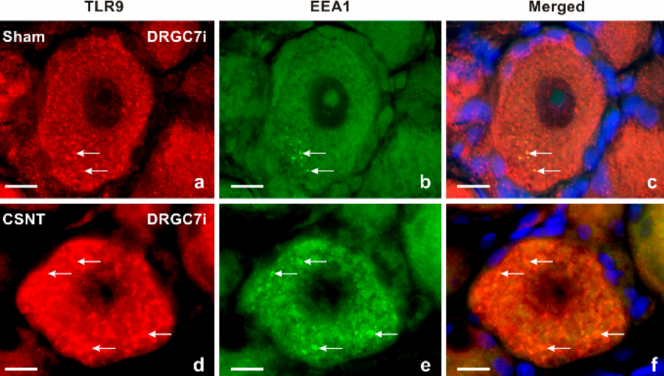
Figure 4. Double immunofluorescence staining for TLR9 and early endosomal antigen 1 (EEA1) as a marker of early endosomes. Sections of cervical DRG ipsilateral (DRGC7i) to sham operation ( a – c ) and CSNT, ( d – f ) were immunostained with rabbit polyclonal anti-TLR9 ( a , d ) and mouse monoclonal anti-EEA1 ( b , e ) antibodies. TLR9 and EEA1 were visualized with TRITC-conjugated donkey anti- rabbit and FITC-conjugated donkey anti-mouse secondary antibodies, respectively. Cell nuclei were detected with Hoechst 33342. A limited number of punctate TLR9 and EEA1 co-immunostaining demonstrated TLR9 protein in early endosomes of cervical DRG neurons of sham-operated rat (arrows in Figure 4a–c). More such punctate double immunostaining was found in the neurons of DRGC7i from CSNT-operated rat (arrows in Figure 4d–f). Scale bars = 10 µ m.